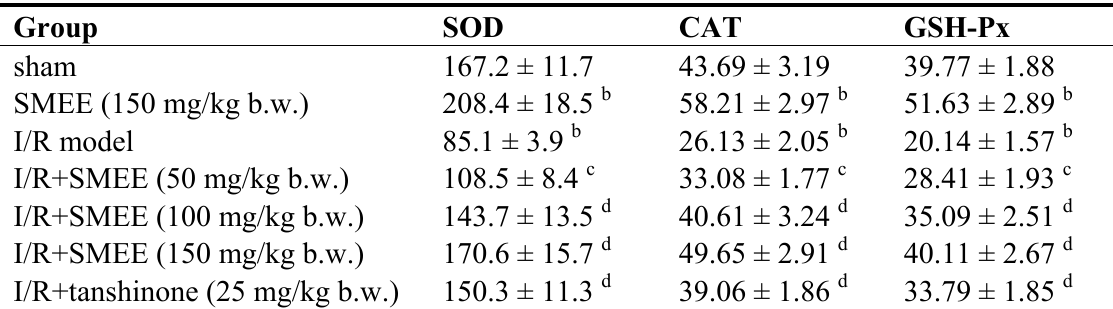
Table 3. Effect of Salvia miltiorrhiza ethanol extract pretreatment on renal SOD, CAT and GSH-Px activities in experimental